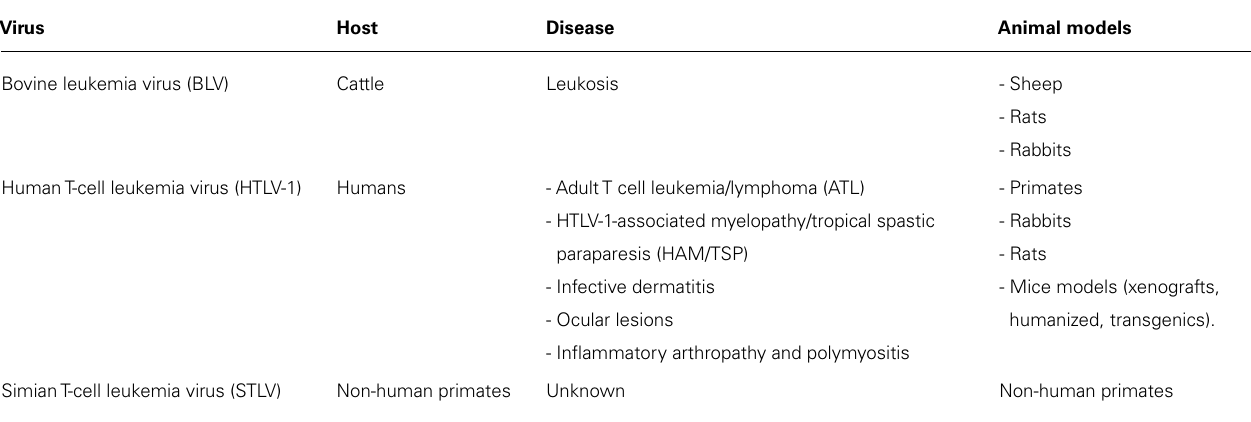
Table 1 | BLV and PTLV: related hosts, diseases, and animal models.